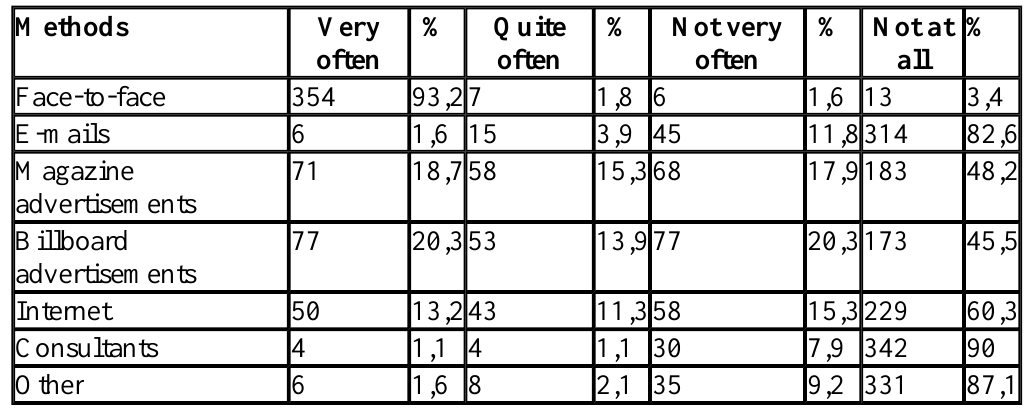
Table 5 Methods of communication used (N =